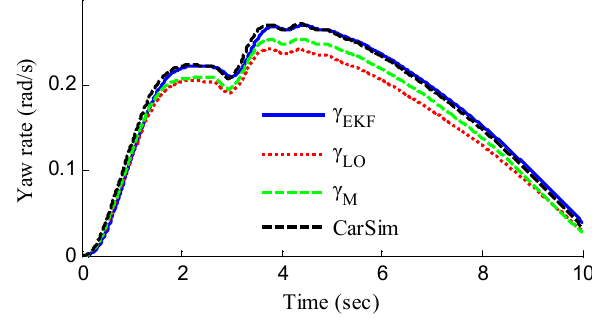
Figure 16. Estimation of yaw rate.